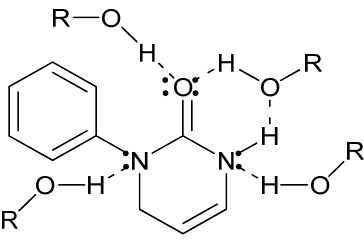
Figure 3 . Stabilisation of pyrimidinone 36a through solvation, in alcoholic